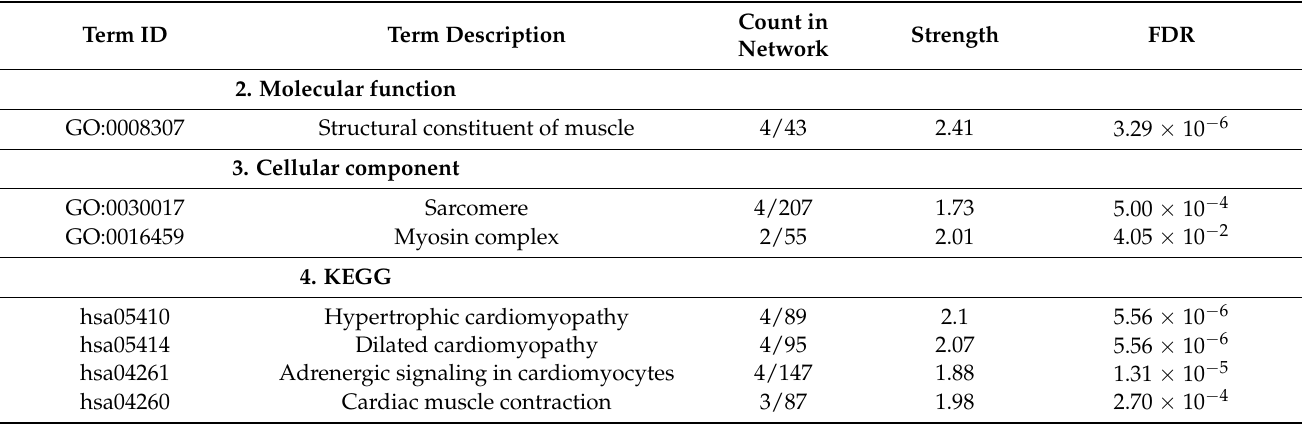
Table 4. Differentially expressed genes at the significant loci for ApoA1 in the Gene Expression Omnibus GSE53201 database. Table 5. Cont.